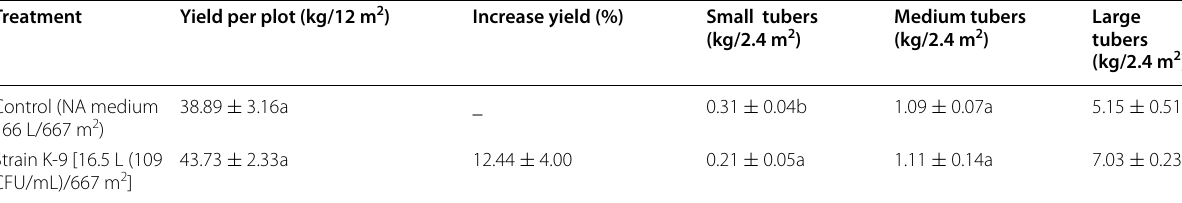
Table 7 Application in planting hole of strain K-9 on potato yield, large potato, and commercial potato percentage